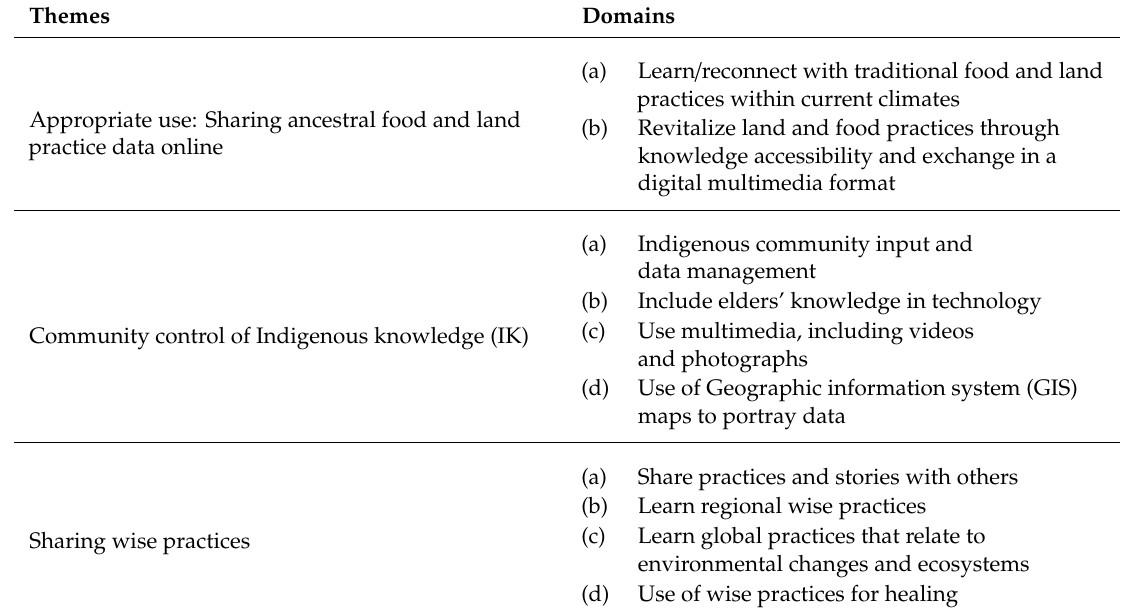
Table 1. Summary of themes and domains using the consensual qualitative